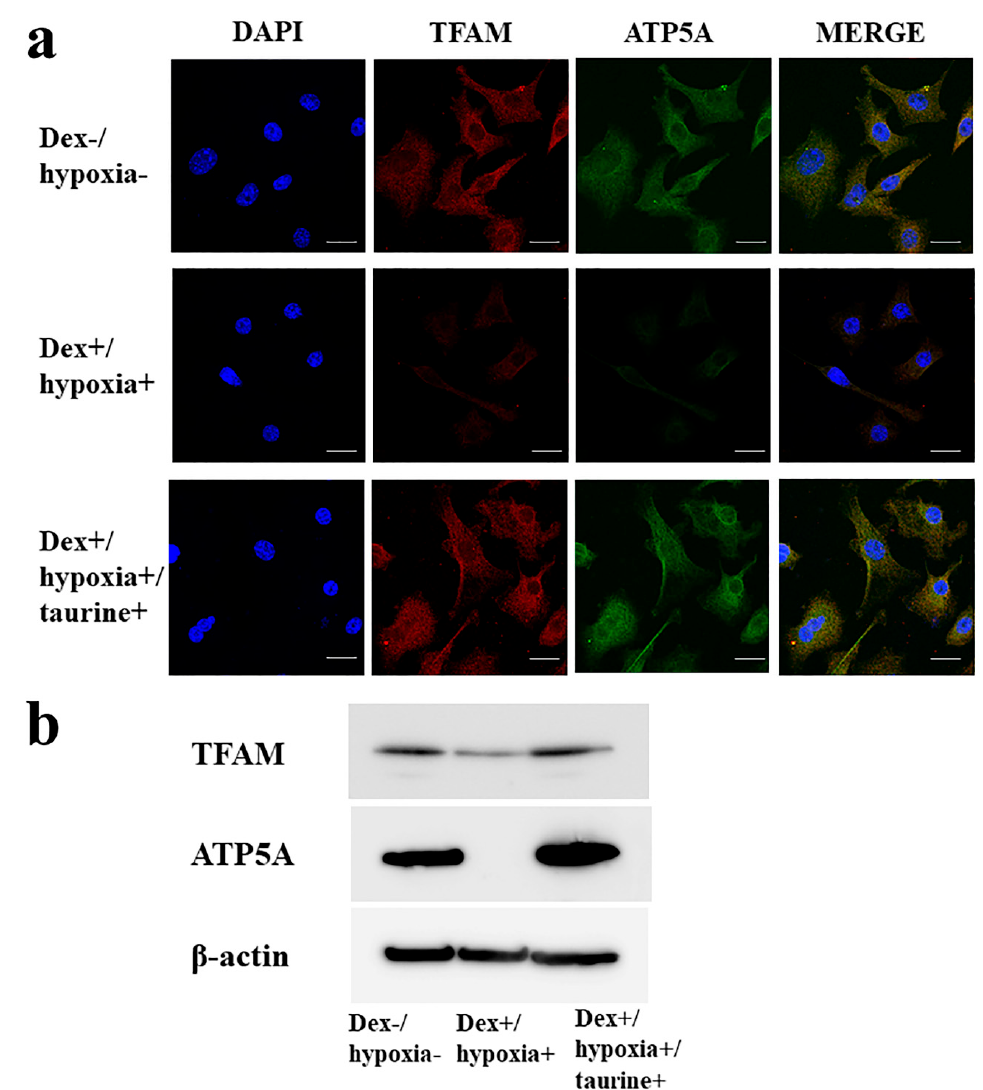
Figure 1. Mitochondrial transcription factor A (TFAM) and ATP5A expression in cultured osteocytes in an H-D stress environment. ( a ) Immunocytochemical study, ( b ) Western blot. TFAM (29 kDa), ATP5A (50–55 kDa), β -actin (42 kDa). In Dex +/ hypoxia + group as compared with Dex − / hypoxia − group, expression of TFAM and ATP5A levels was decreased. In Dex +/ hypoxia +/ taurine + group with addition of taurine, as compared with Dex +/ hypoxia + group, levels of both TFAM and ATP5A expression were increased. Scale bar: 20 µ